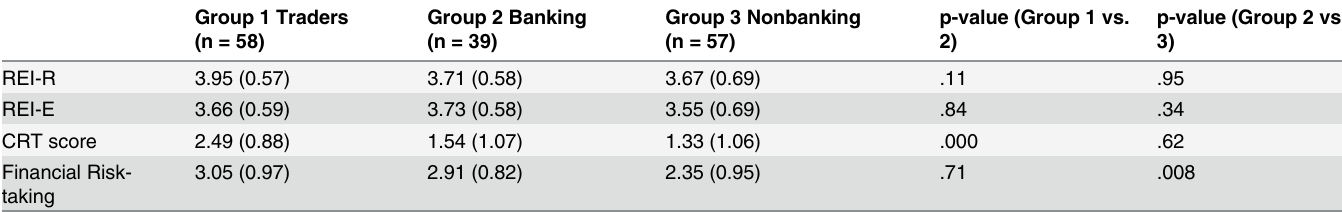
Table 4. Means and standard deviations for risk-taking, cognitive style, and cognitive reflections scores across all three groups. Group 1 Traders (n =